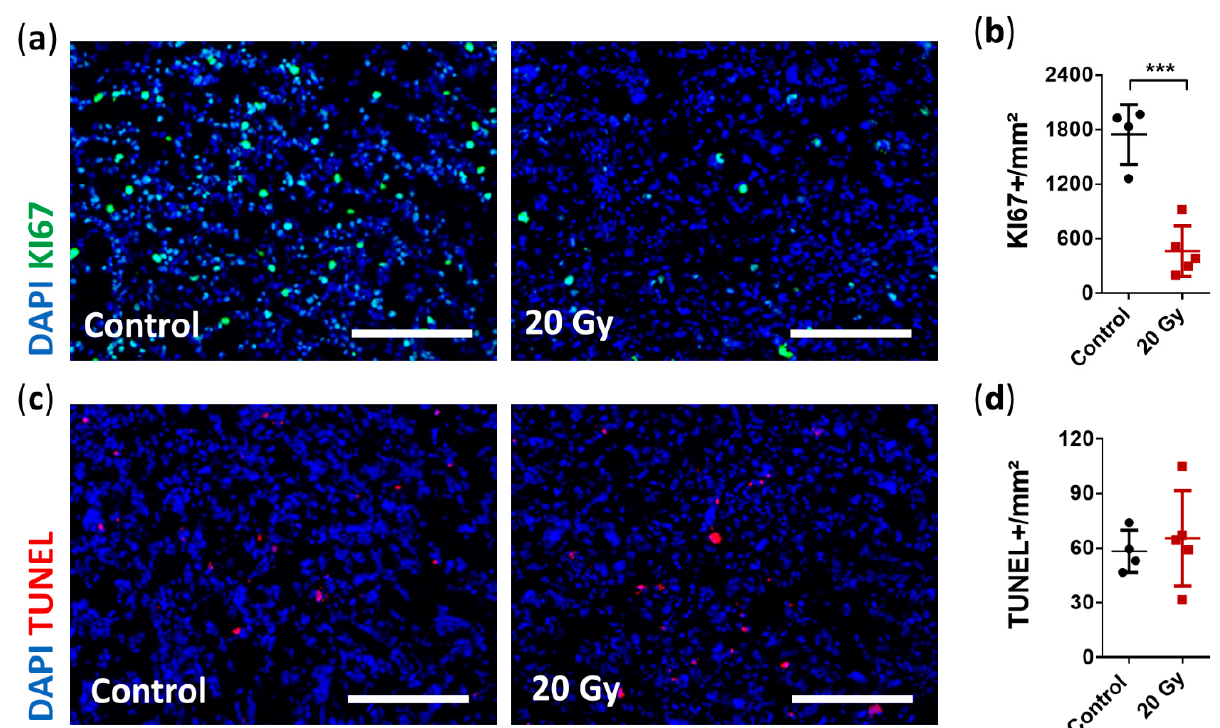
Figure 4. Immunohistological analysis of early radiobiological effects on cellular proliferation and apoptosis. ( a ) Repre- sentative immunostaining images showing severely impaired proliferation activity after irradiation (Ki67: green, DAPI: blue; scale bar = 200 µ m). ( b ) Quantification of cellular proliferation demonstrated a decrease by 79% in irradiated tumors compared to non-irradiated tumors (data are presented as the mean ± SD of each group. Individual values of each animal are provided as a single dot; n = 4–5 per group; *** p < 0.001). ( c ) Representative immunostaining images showing no change in cell apoptosis (TUNEL: red, DAPI: blue; scale bar = 200 µ m). ( d ) Quantification of apoptotic cells showed similar amounts of TUNEL-positive cells per mm 2 between the irradiated and non-irradiated tumors (data are presented as the mean ± SD of each group. Individual values of each animal are provided as a single dot; n = 4–5 per group).